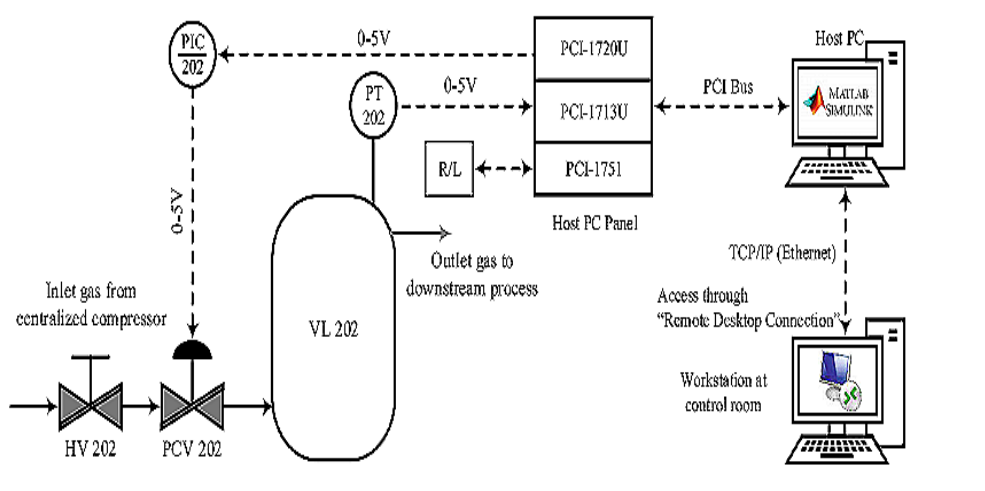
Figure 3. A block diagram of the single-tank system simulated in MATLAB for extracting failure data.